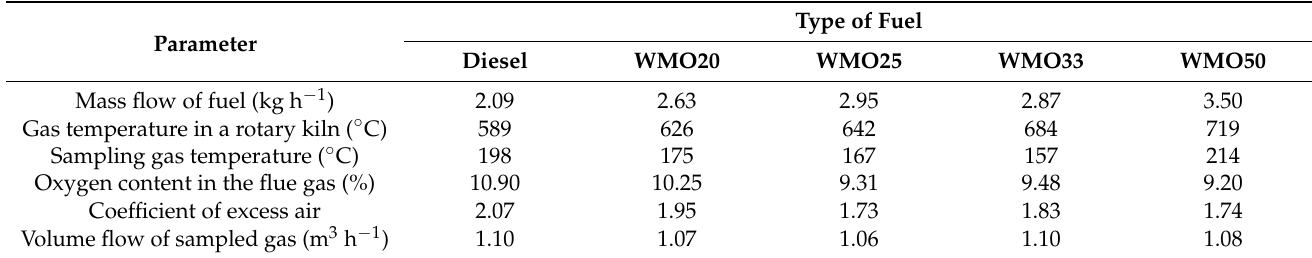
Table 3. Medium measured values of fuel combustion parameters.